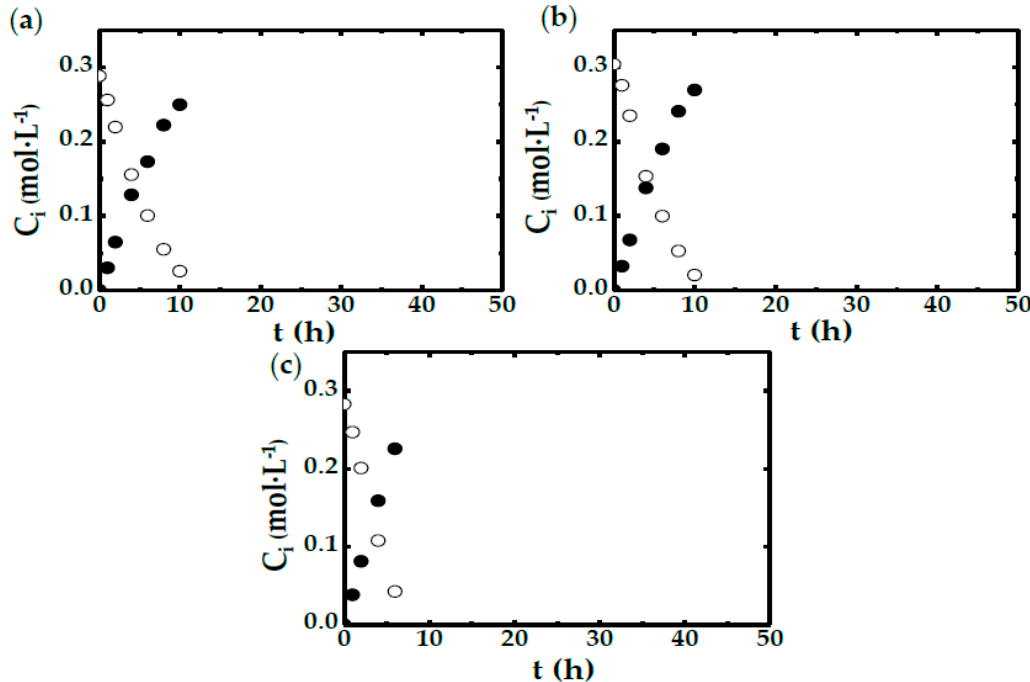
Figure 4. Experimental results. DHA ( ● ) and glycerol ( ○ ) concentrations vs. time for runs 17 to 19 (see Table 1) carried out in shake flasks. All runs conducted at agitation speed of 300 rpm employing different biomass concentrations according to ( a ) 0.4, ( b ) 0.5, and ( c ) 1.0 g·L − 1 .